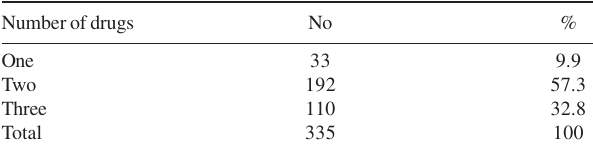
Table 2 – Characteristics of chemotherapy.